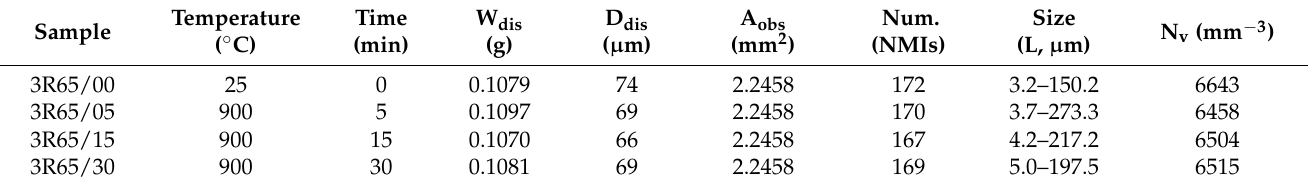
Table 15. The characteristics of elongated sulfides in different steel samples of 3R65 after heat treatment using Method 2. Sample